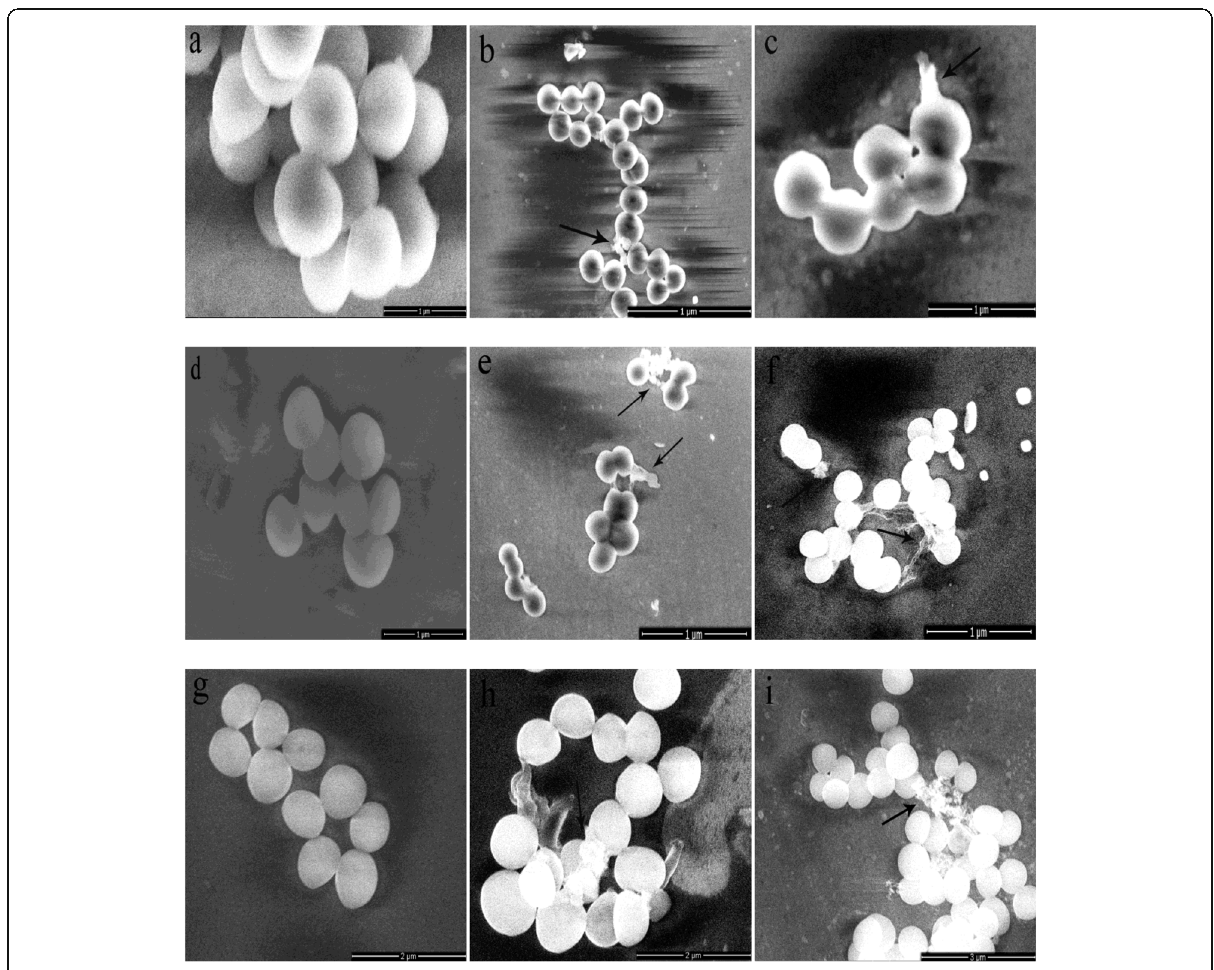
Fig. 5 SEM images of SA ( a , b and c ), MRSA ( d , e and f ) and ESBLs-SA ( g , h and i ) treated by chelerythrine for 1.5 h ( b , e and h ), 6 h ( c , f , i ); and control ( a , d and g